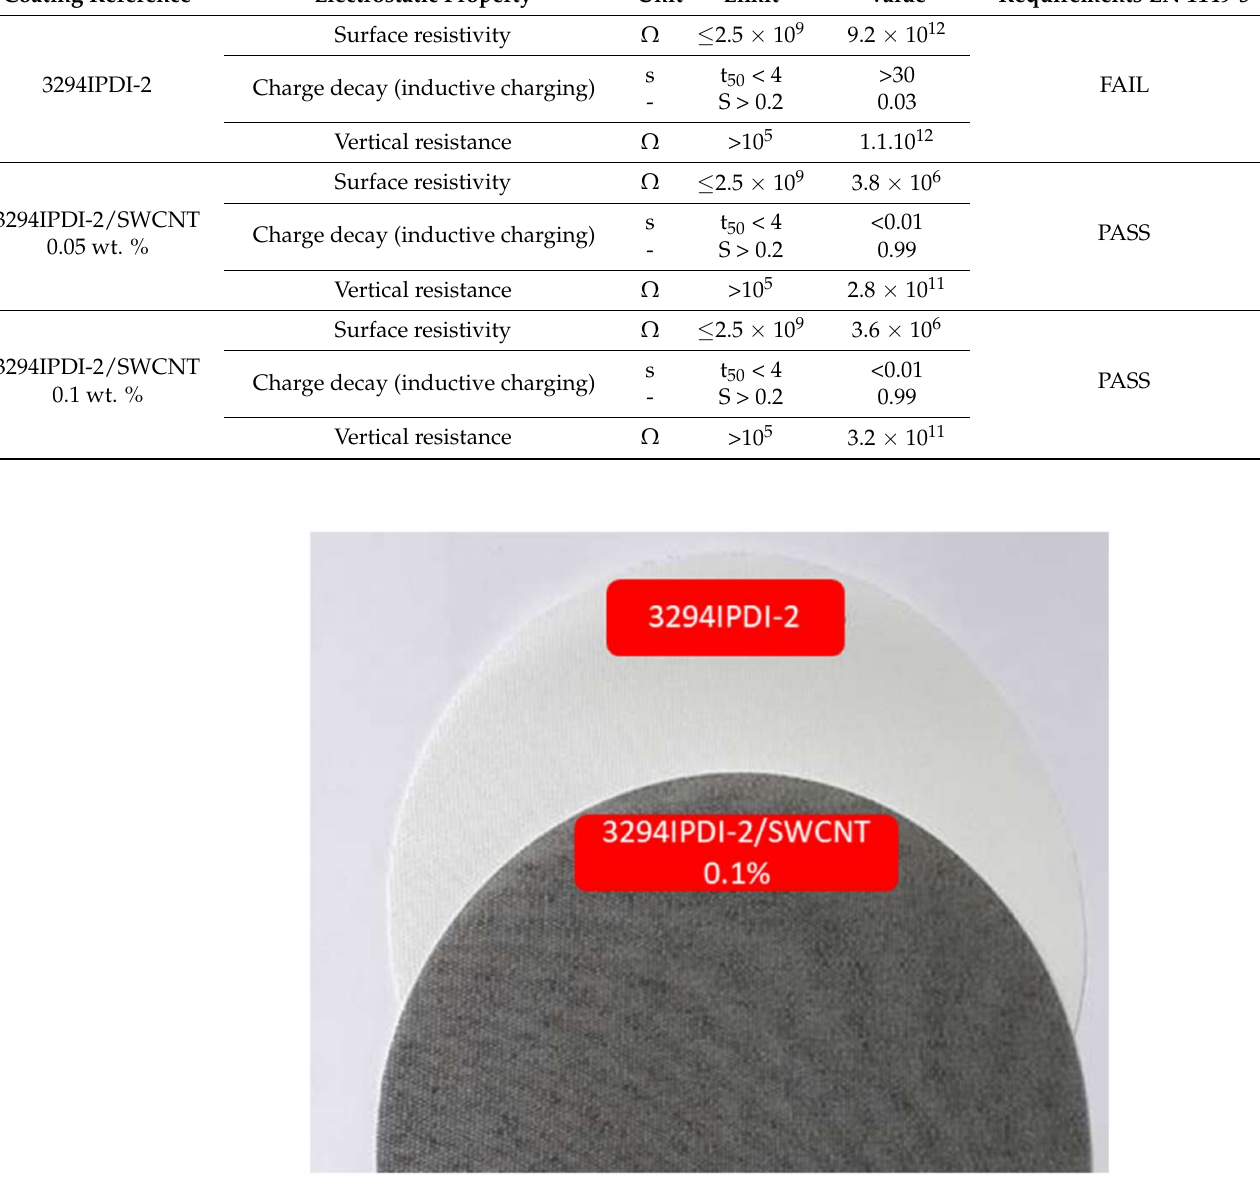
Figure 20. Appearance of UPRON fabric coated with: ( top ) 3294IPDI-2 and ( bottom ) 3294IPDI-2 dopped with 0.1 wt. %